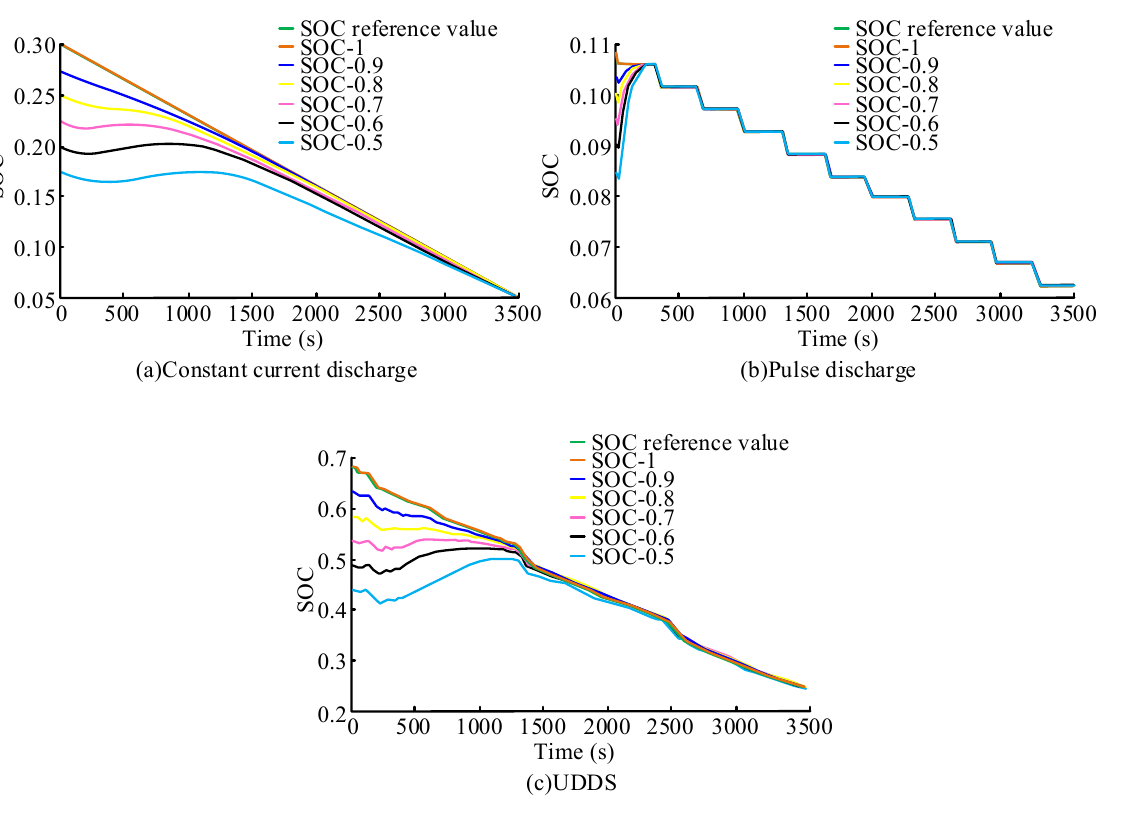
Figure 9. Model estimation effect under six initial SOC values.